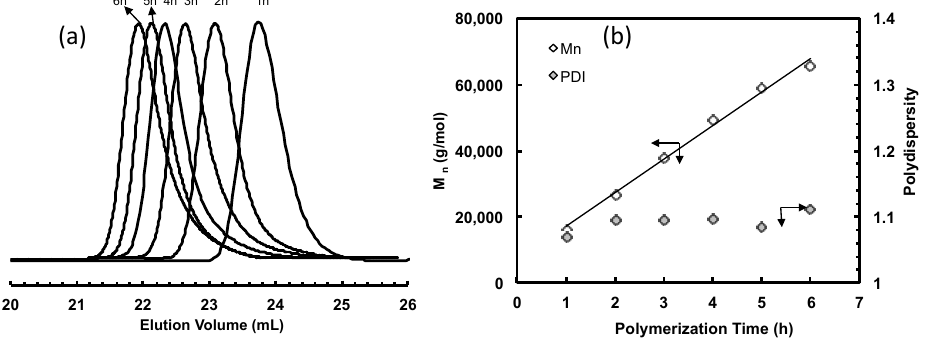
Figure 3. ( a ) GPC elution curves for polyethylene samples taken at different polymerization time in ethylene polymerization using 2 at 5 °C and 400 psi in chlorobenzene; and ( b ) plot of M n and PDI as functions of polymerization time.